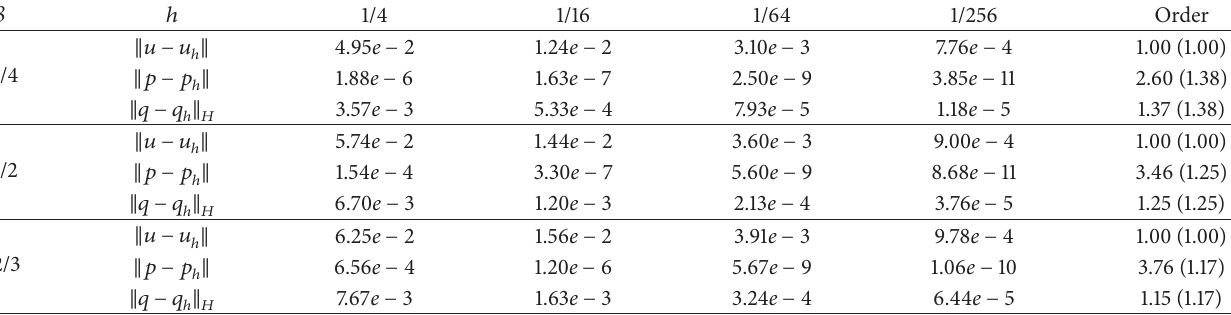
Table 5: Numerical result of Example 3 on a uniform mesh of size ℎ for 𝑘 = 1 .